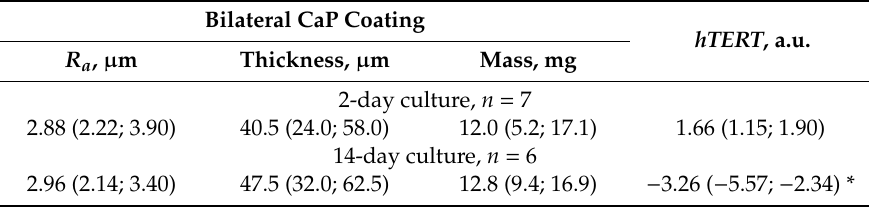
Table 2. hTERT expression in Jurkat T cells after di ff erent culture times in the presence of a CaP coating on a titanium substrate; Me (Q 1 ; Q 3